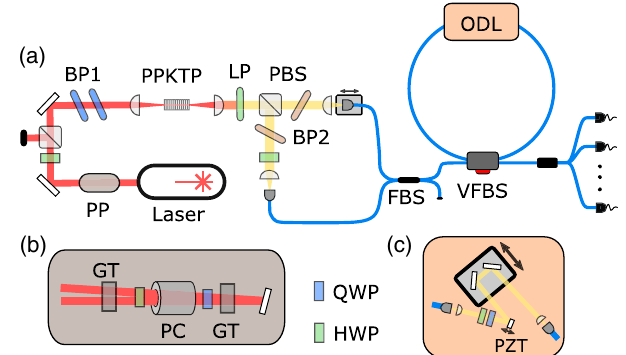
FIG. 3. (a) Main experiment setup. PP, pulse picker; BP1, bandpassfiltersat775nm;PBS,polarizingbeamsplitter(Wollaston prism); BP2, bandpass filters at 1550 nm; FBS, fiber beam splitter; VFBS, variable FBS; ODL, optical delay line; and LP, long pass filter. (b) Detailed schematic of the pulse-picking system, indicated as PP in (a). GT, Glan-Taylor polarizer; PC, Pockels cell; QWP, quarter-waveplate;HWP,half-wave plate.(c)Detailedschematicof the free-space optical delay in the single-loop interferometer, indicated as ODL in (a). PZT, piezoelectric